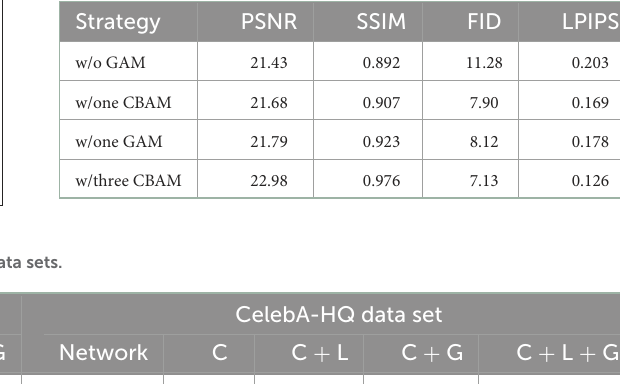
TABLE 4 The ablation of attention mechanism on CelebA.